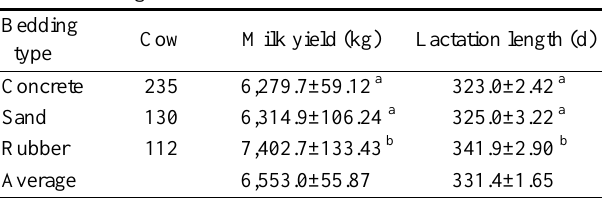
Table 2. Means (±SE) of milk yield and lactation length on three different resting surfaces